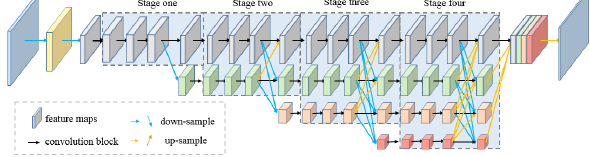
Figure 1. A simple example of the high-resolution networks.